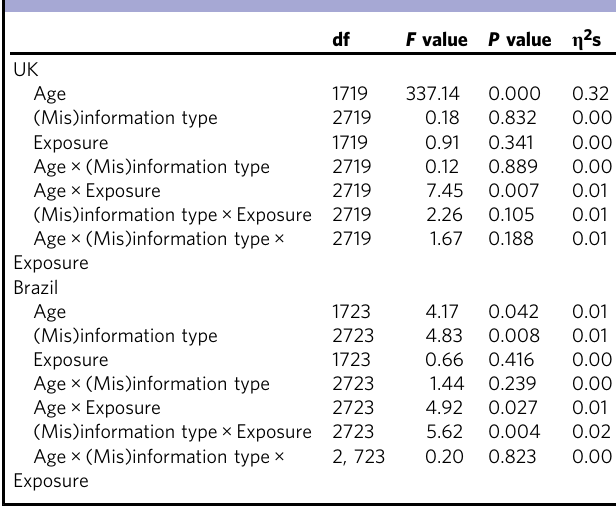
Table 1 Main and interaction effects of age, (mis) information type, and exposure on misinformation